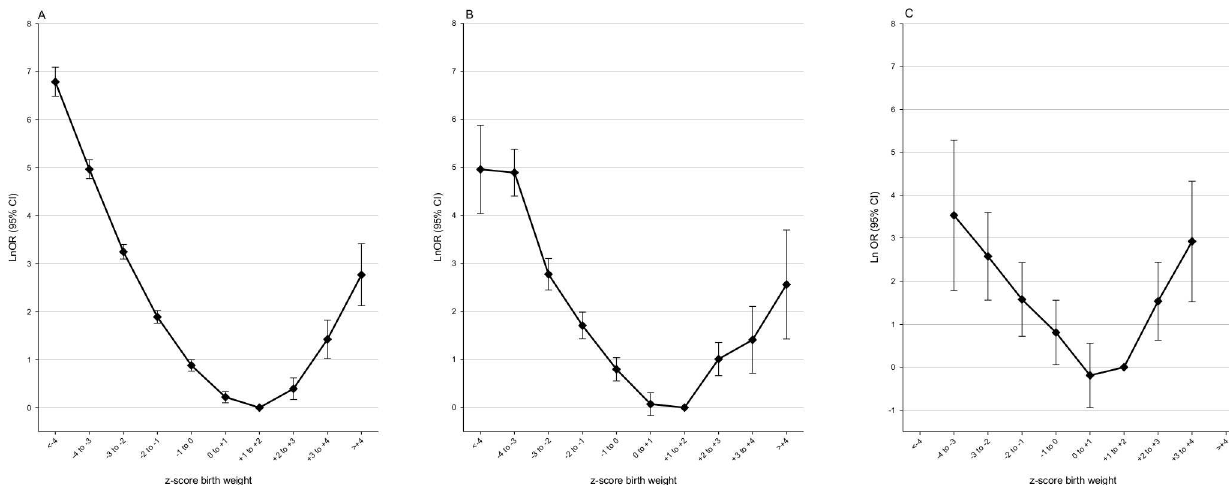
Fig 4. Associations between perinatal death and zBW in selected population subsets. BMI: Body Mass Index; CI: confidenceinterval; OR: odds ratio; zBW: z-score birth weight, standardized for year of birth, sex, birth order, gestational week, and plurality. (A) Births 1967–1998,